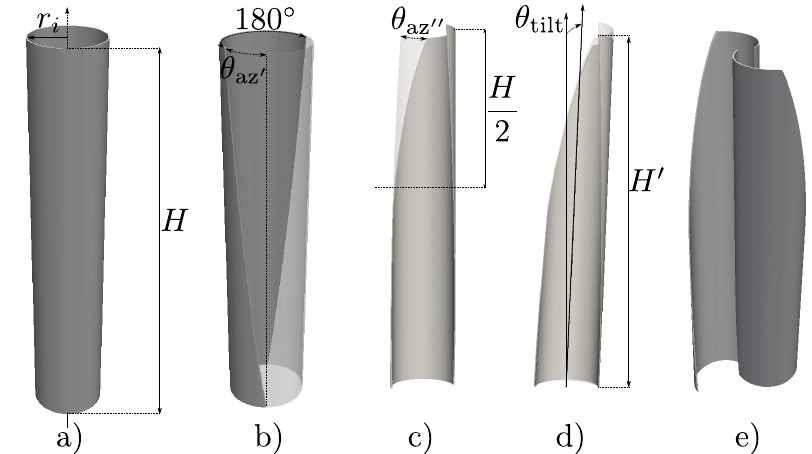
Figure 1. Schematic of the twisted blades’ manufacturing process. ( a ) Availability of a hollow cylinder (tube) with an inner radius r i and a height H . ( b ) Two symmetric twisted cuts with an azimuthal angle θ az (cid:48) all over along the tube, such that the remained material covers 180 ◦ (or less, as it is desired). ( c ) A secondary H twisted cut over an azimuthal angle θ az (in the range of 90 ◦ ), starting from the half height . ( d ) A rotation (cid:48)(cid:48) 2 with a tilt angle θ tilt over the central axis—followed by a perpendicular cut on the extremes (endings), resulting in a single twisted blade with a new height H (cid:48) . ( e ) The two twisted blades are placed opposite and symmetric to a rotational axis for the resulting